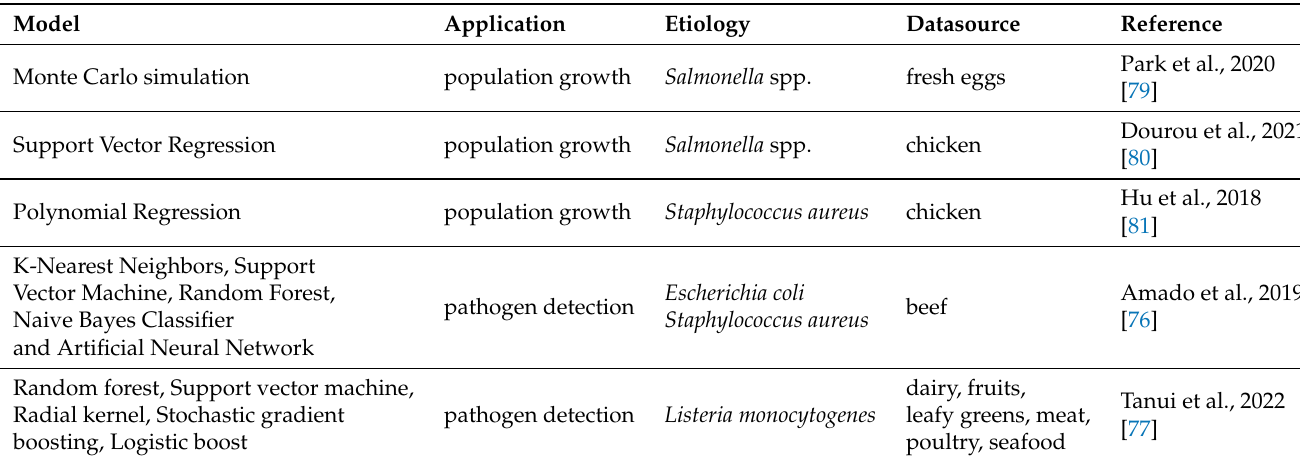
Table 2. Summary of models and their applications in foodborne